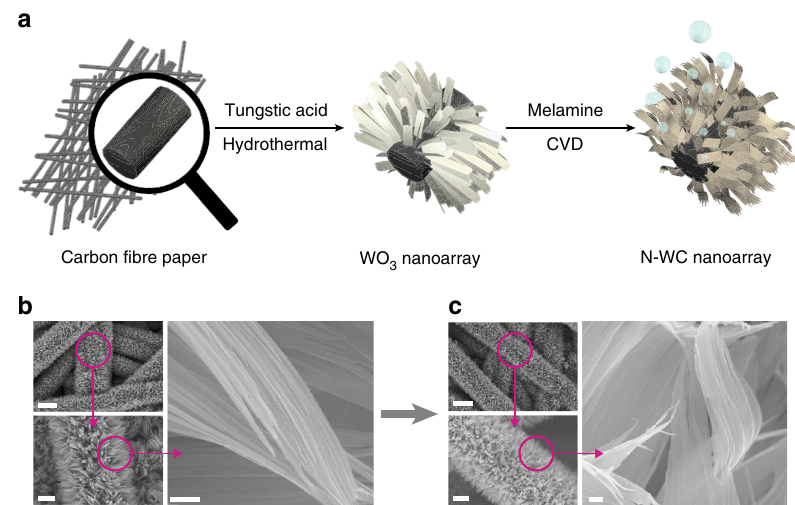
Fig. 2 Fabrication of N-WC nanoarray electrodes for HER. a Schematic illustration: WO 3 nanoarray on CFP were synthesized by a non-template, self- assembled hydrothermal reaction of tungstic acid; then the WO 3 nanoarray was reduced, carbonized, and N-doped with melamine at high temperature to get N-WC nanoarray, which was used directly as high performance HER or OER catalytic electrode. b SEM of WO 3 nanoarray. c SEM of N-WC nanoarray. Scale bar in b and c : left top 20 μ m, left bottom 5 μ m, right 200